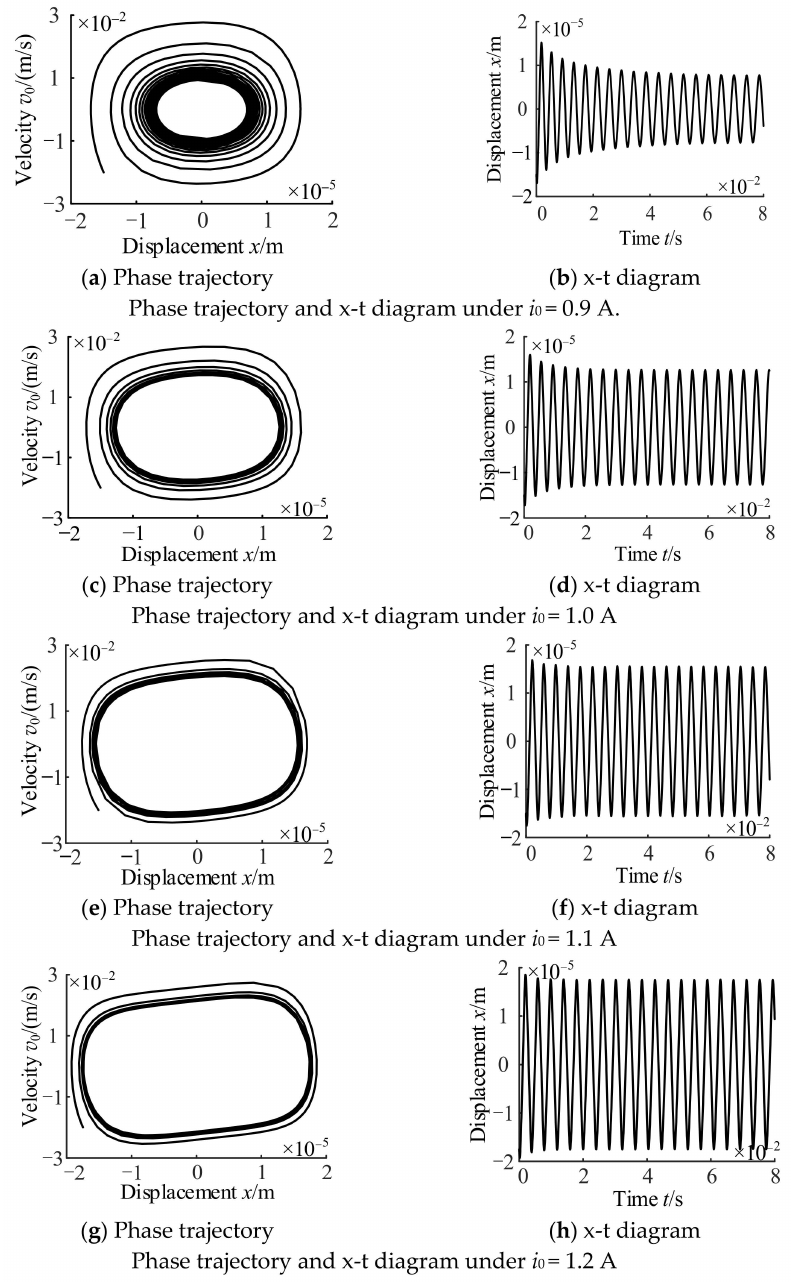
Figure 8. Phase trajectory and x-t